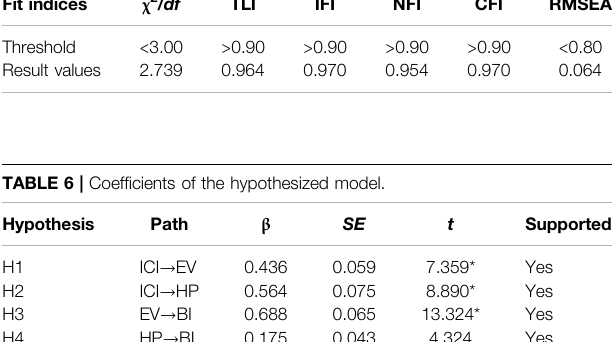
TABLE 4 | Correlation coef fi cient matrix and square roots of AVE ( n = 419). Construct